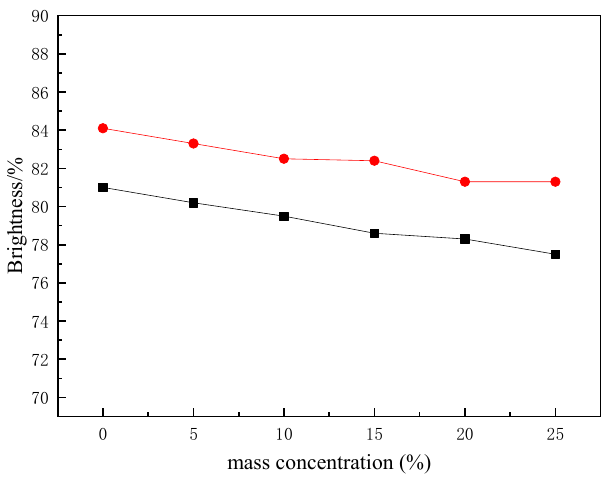
Figure 8. Brightness of the paper treated with different mass concentrations of polyurethane. ■ , R457; ●, Ry.